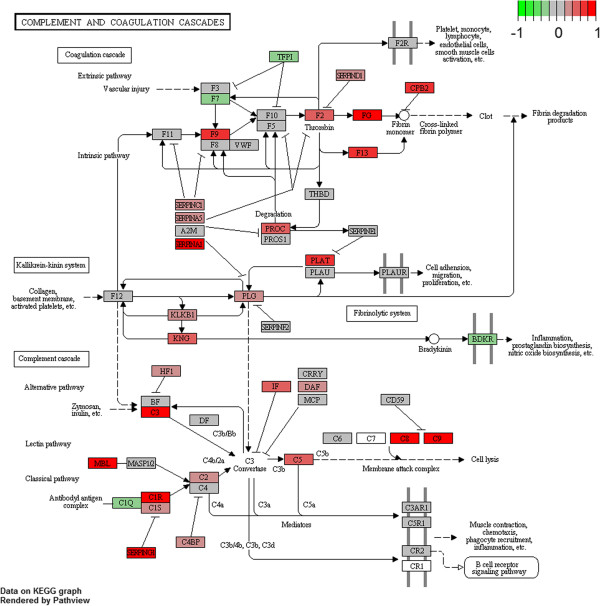
Complement and coagulation cascades pathway from KEGG. Genes are colored according to their GSEA calculated scores in R6/2 versus WT analysis (signal-to-noise): the most marked red genes belong to the core enrichment.